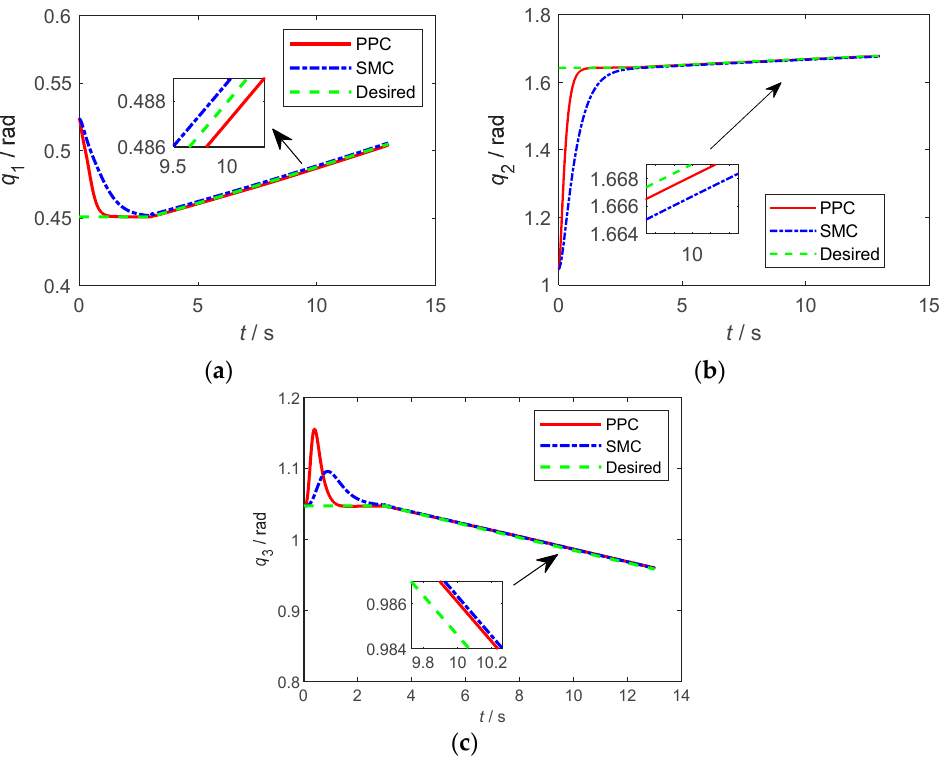
O , ( b ) The 1 ' ' ' X O Y .